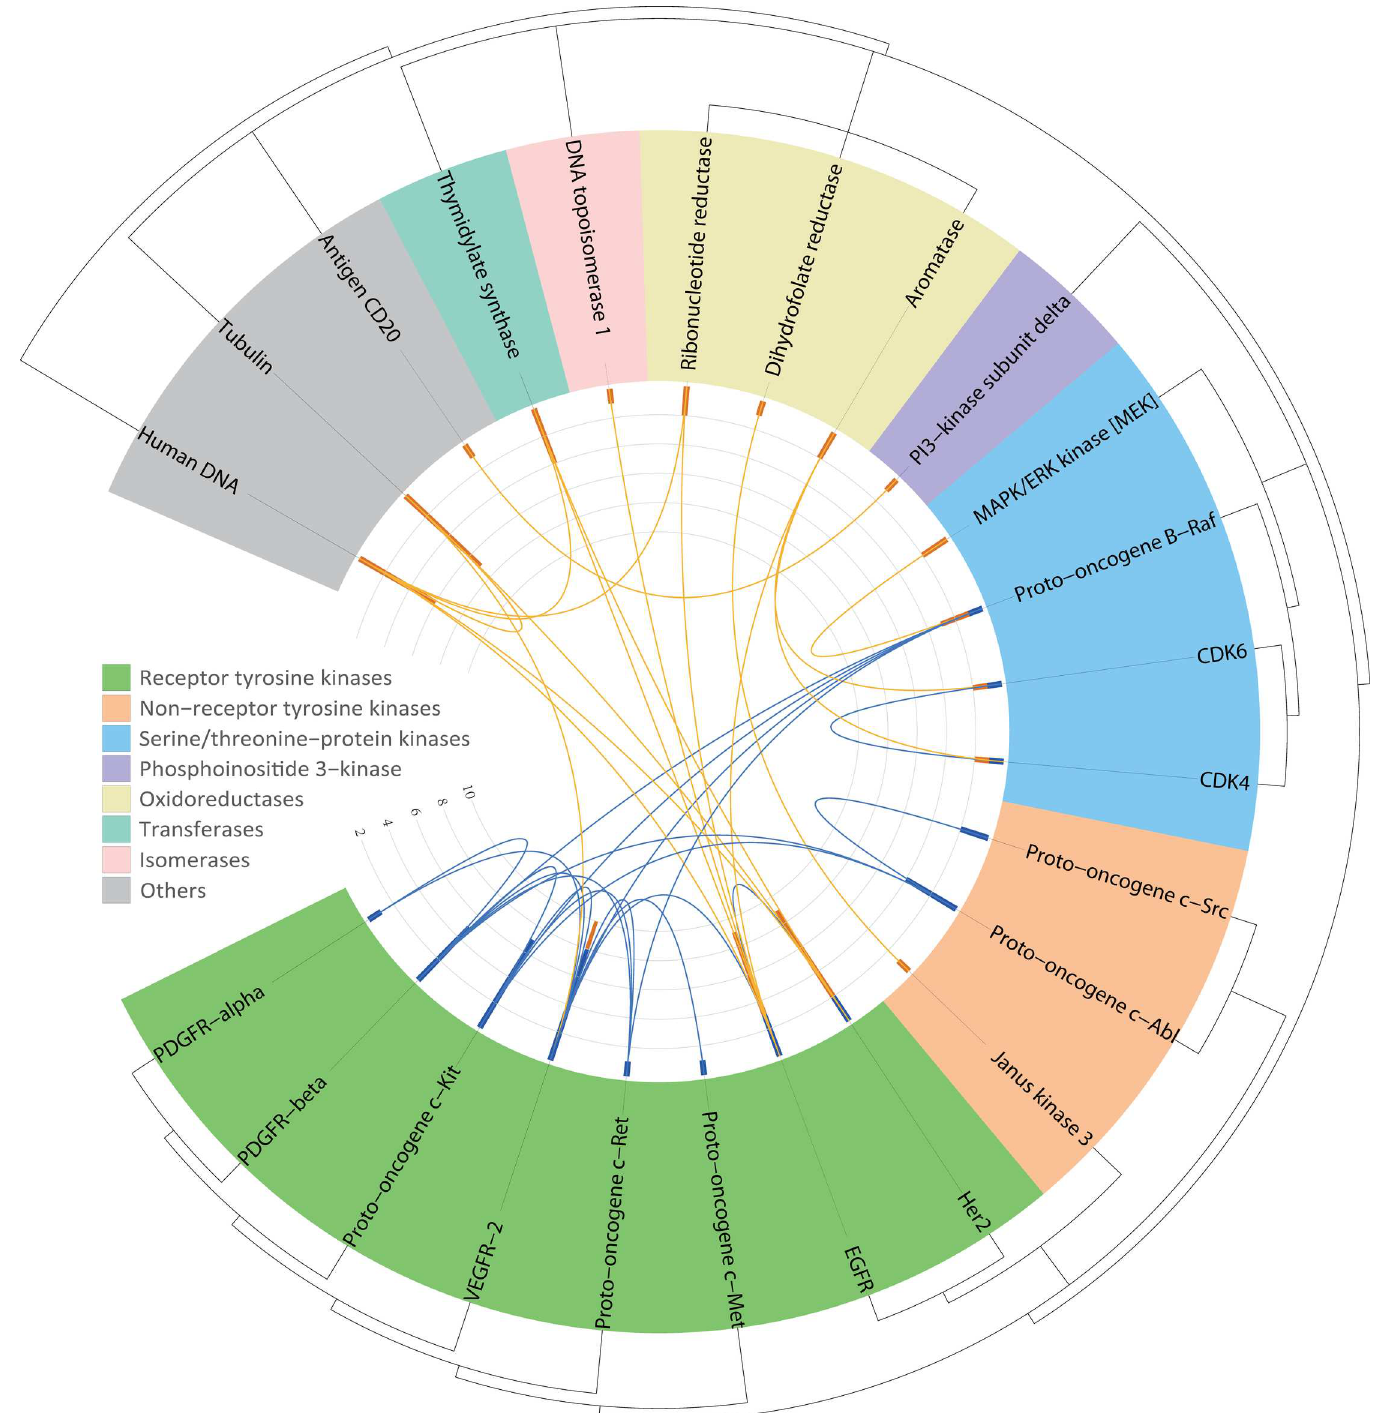
Fig 6. Phylogenetic tree representing the homology distance among all targets targeted by approved multi-target drugs and combination products. The connections shown in the center representedthe target pairs aimed by the multi-target drugs (lines in blue) and the combination products (lines in orange).Bars at the end of each connectingline definedthe number of multi-target drugs (blue bar) and combination products (orange